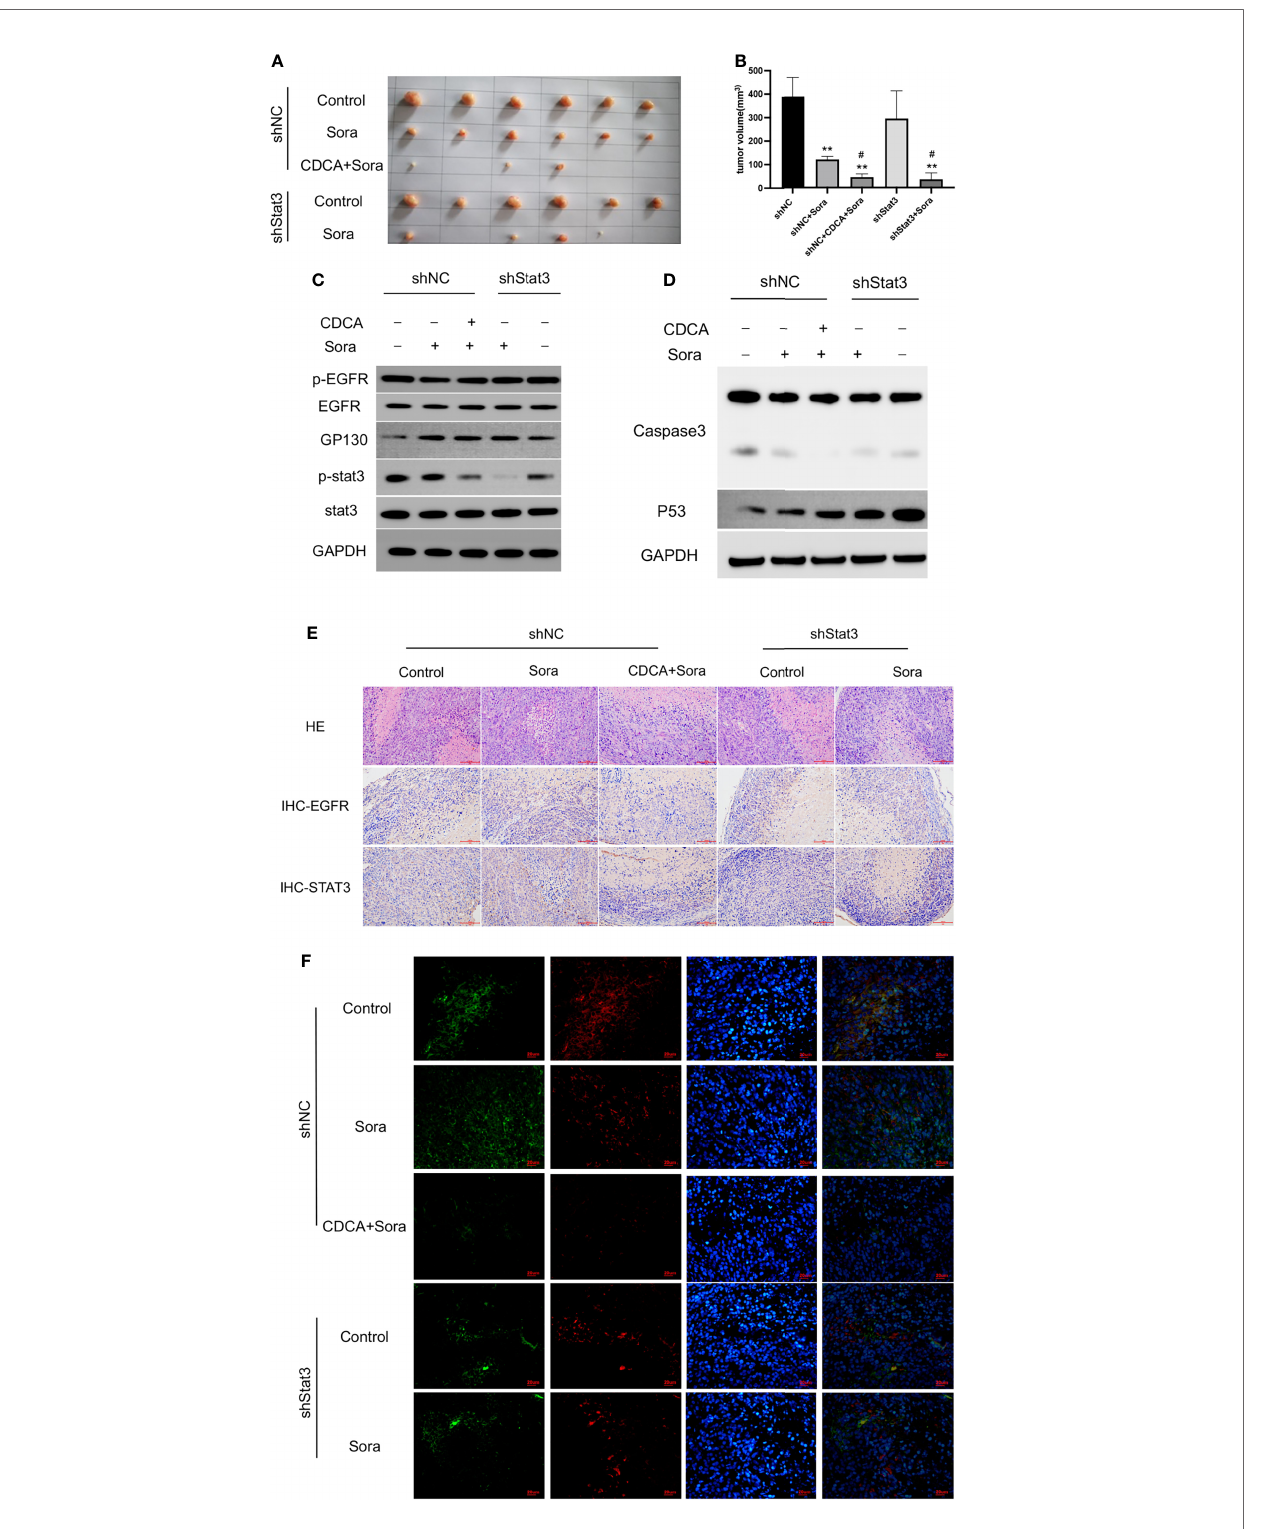
FIGURE 5 | In vivo validation of the effect of CDCA on Stat3. The knockdown Stat3 cells were transplanted into nude mice, and the rest of the operation was performed as in previous in vivo experiments. (A) Transplanted tumors. (B) Transplanted tumor volumes. ** P < 0.01 vs. shNC, # P < 0.01 vs. shStats. (C) EGFR and Stat3 protein and phosphorylation levels. (D) Caspase 3 and p53 protein expression. (E) HE and immunohistochemical staining of tumor tissues (20x). (F) Immuno fl uorescence staining of tumor tissues